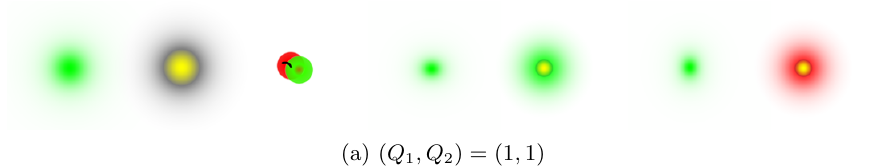
Figure 15 : Q 1 = Q 2 = Q minimal \normal" vortex with Q = 1. The (cid:12)gure contains 7 elements from left to right: for column 1 through 3: v 1 =v 2 = 1: an energy density plot, a (cid:12)eld density plot and a sketch of how the red and green vortices are interconnected. For column 4 and 5: v 1 =v 2 = 2: an energy density plot and a (cid:12)eld density plot. For column 6 and 7: v 1 =v 2 = 1 = 2: an energy density plot and a (cid:12)eld density plot. All columns except column 3 are made using the coloring scheme of (cid:12)gure